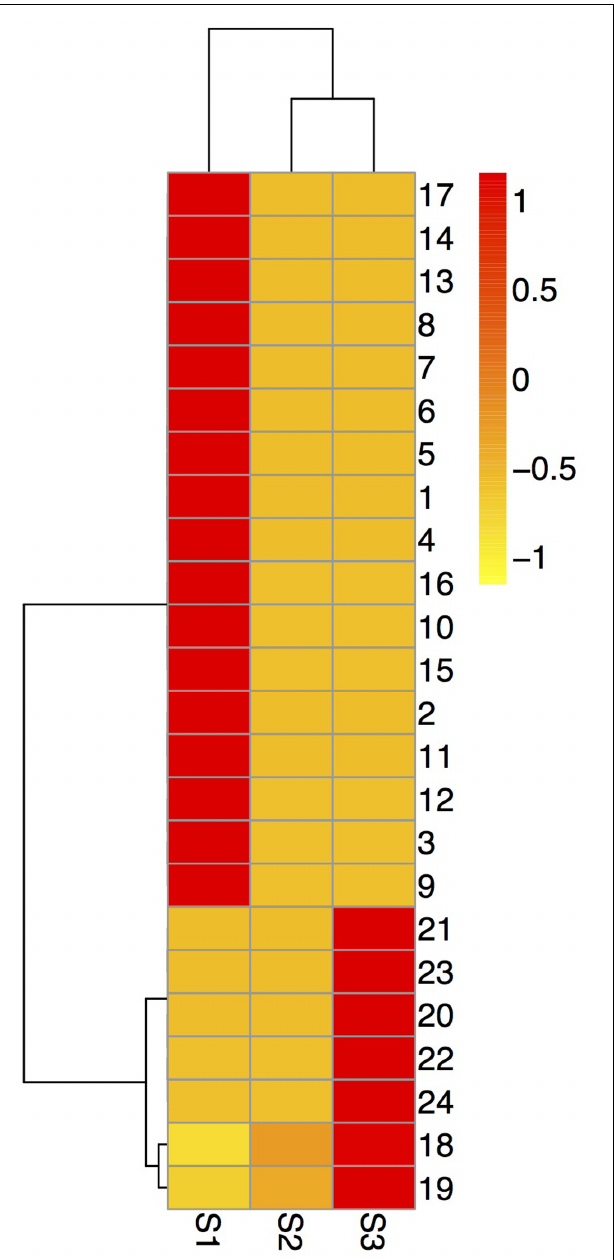
FIGURE 2 | Hierarchical cluster analysis of the expressed proteins during alfalfa flower development. Dataset clustering was implemented in R (version 3.2.2) after normalization of the expression abundance values. Each colorized cell represents the averaged spot quantity, according to the color scale on the right of the figure. S1: pre-pollinated stage (fully opened with the keels still closed); S2: pollinated stage (2 h after pollination); S3: post-pollination senesced stage (24 h after pollination); 1-24: spot